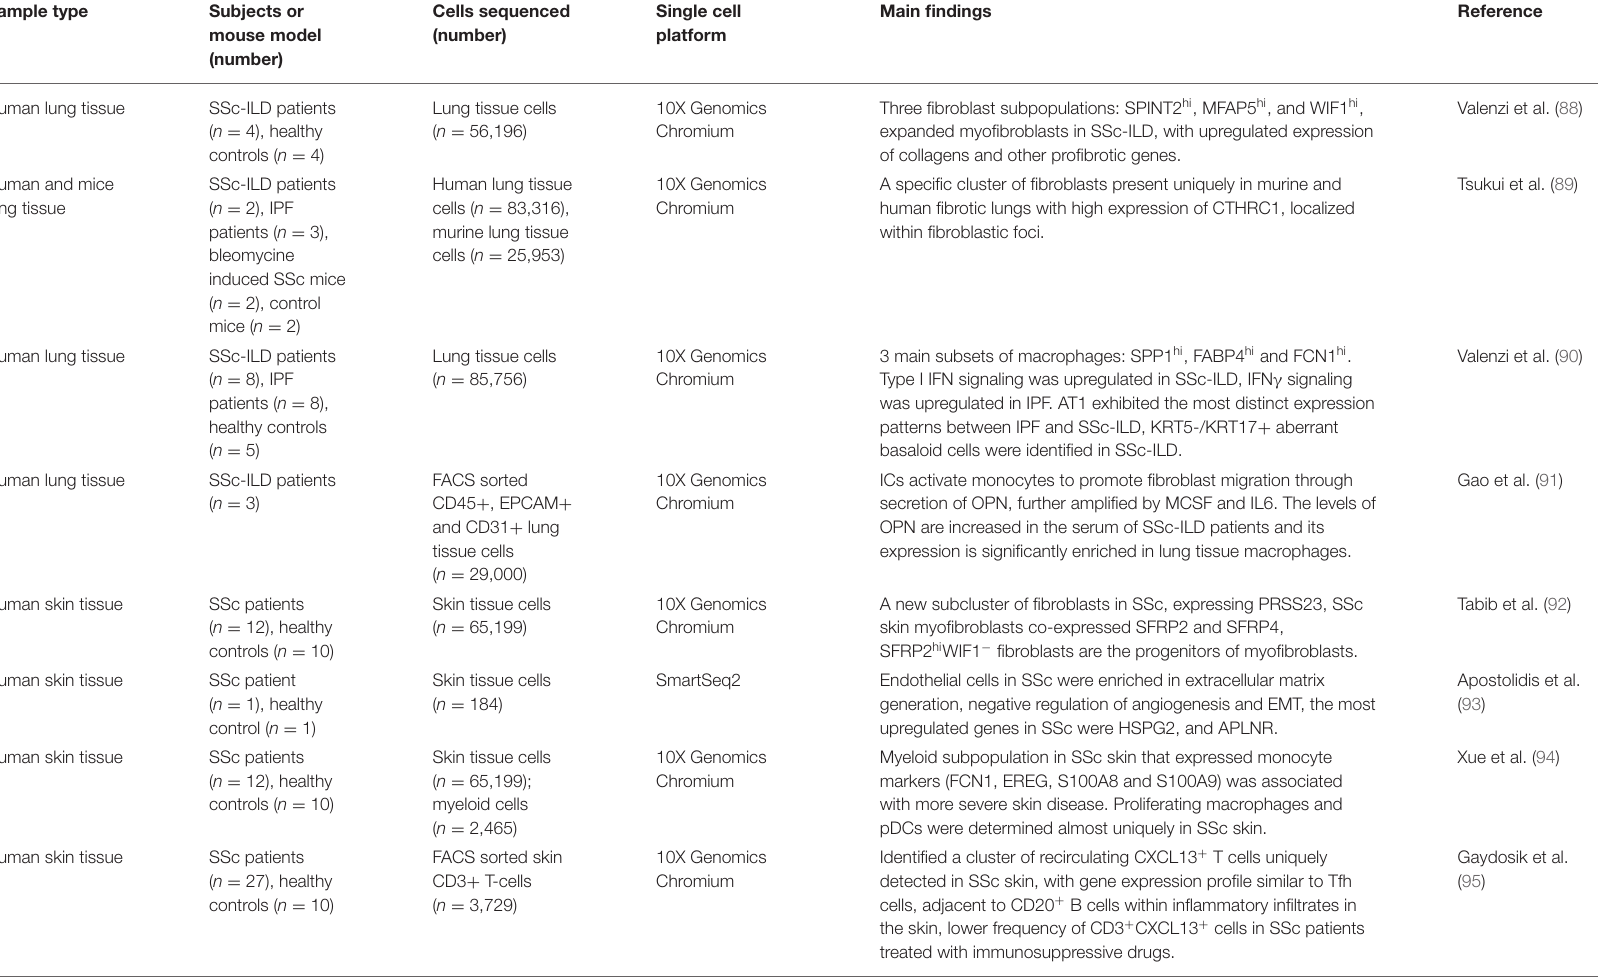
TABLE 3 | Application of scRNA-seq technology in systemic